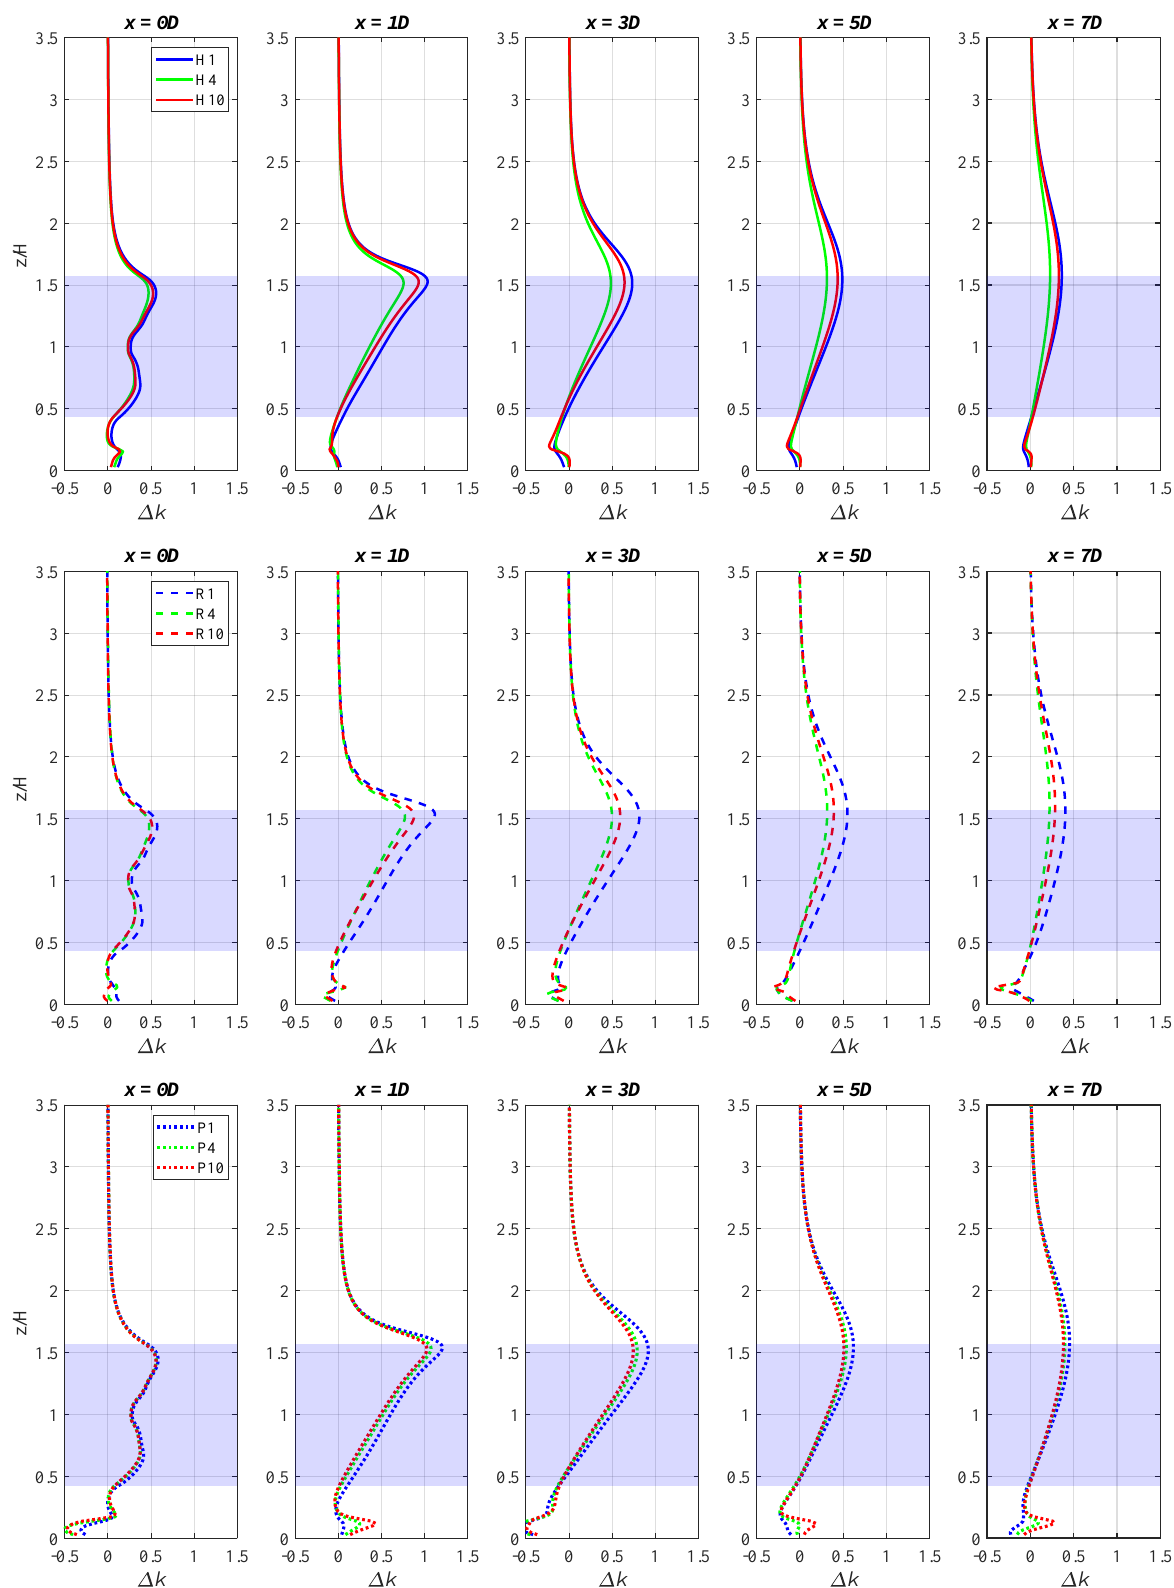
Figure 19. Vertical profiles of TKE deficits ( ∆ k) from the midplane in different heterogeneous cases with varying densities; ( up ) homogeneous cases, ( middle ) real cases, ( down ) patched cases. The purple shaded region is the turbine rotor